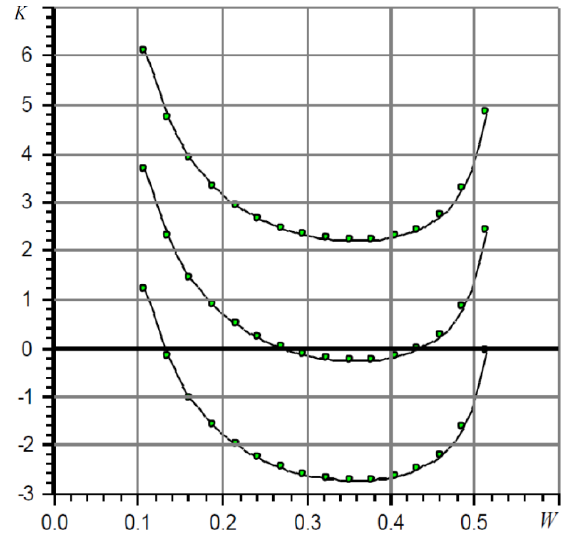
Figure 6. Bearing compliance K in the load range W , χ = 0.5, R 1 =